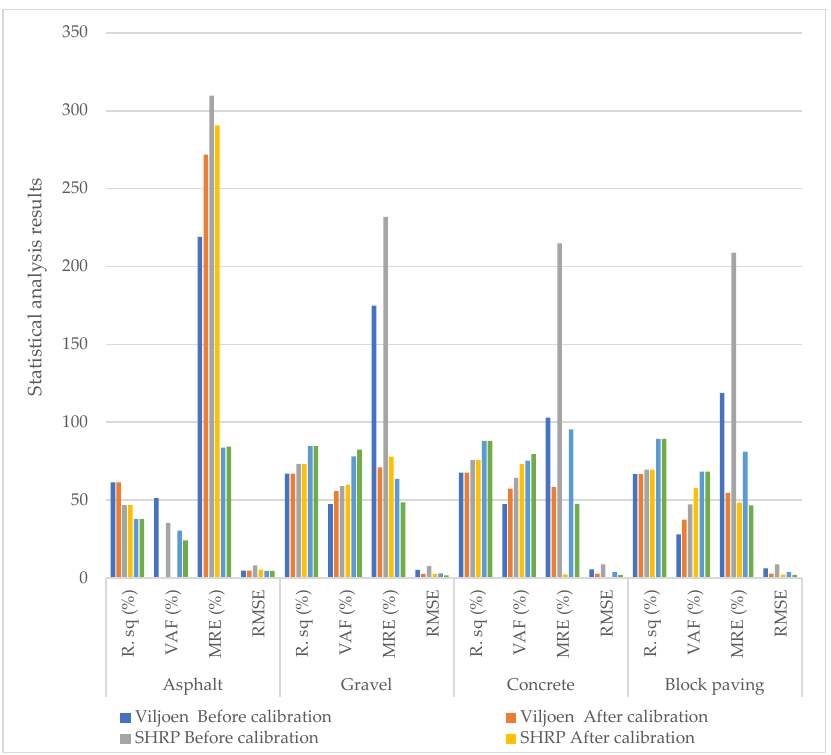
Figure 2. Comparison of statistical analysis results for uncalibrated and calibrated predicted mini- mum temperatures.